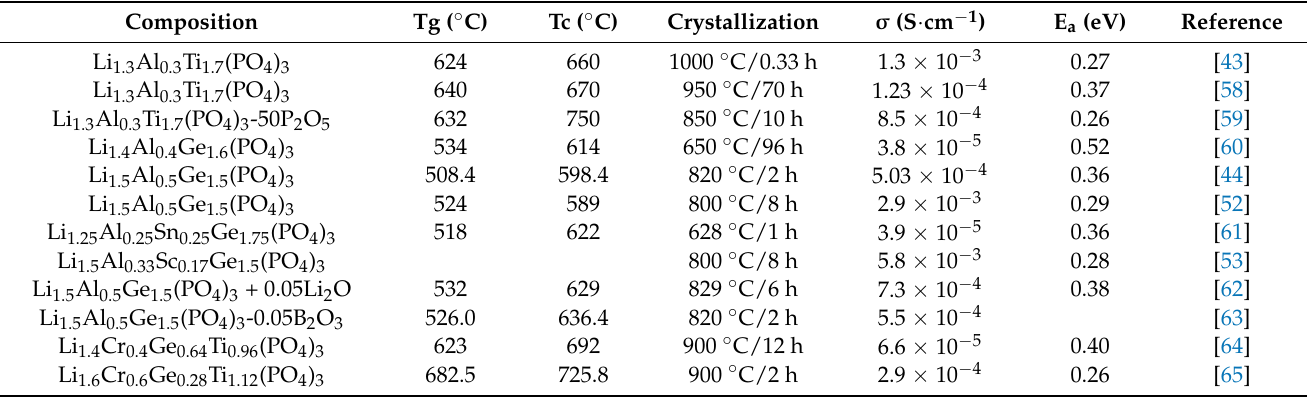
Table 1. Review of various parameters of NASICON-type glass-ceramic materials prepared by melt-quenching method in recent years.